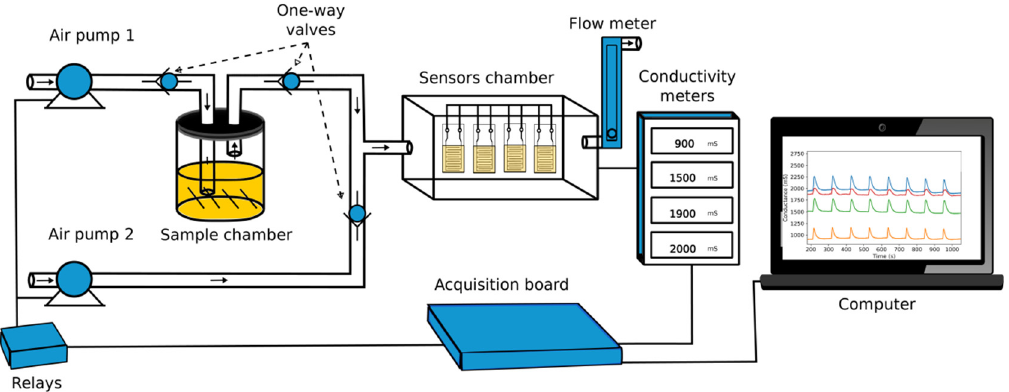
Figure 2. Schematic representation of the electronic nose assembled.